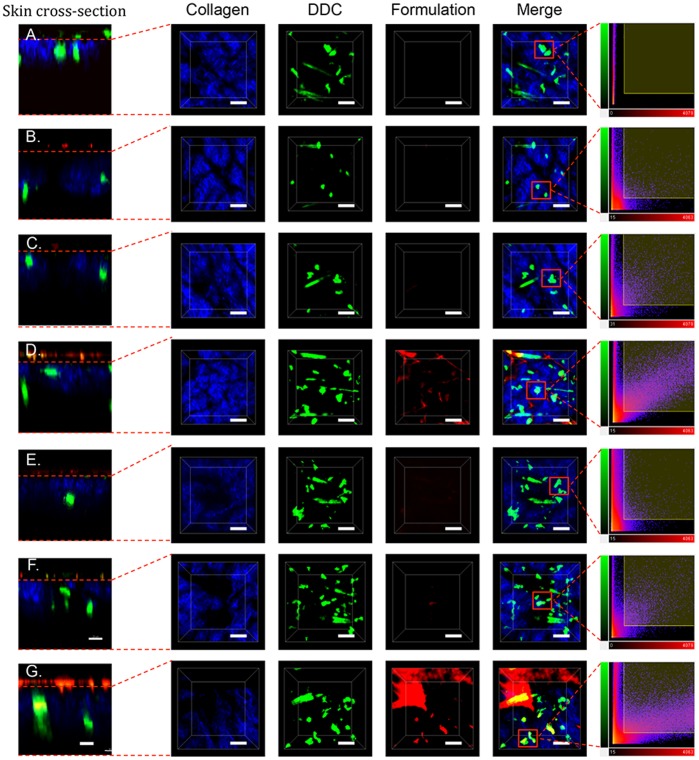
Formulation-DDC colocalization.Two-photon microscopy (2 PM) visualization of collagen (blue), DDC (green) and vaccine (red) in the dermis of untreated mice (A) or 40 min following application of an aqueous TMR-SIINFEKL mixture (B, E), rhodamine-labelled cubosomes (C, F), or TMR-SIINFEKL-loaded cubosomes (D, G) to intact (B-D) or MN pretreated (E-G) skin. Cross sections (XZ, far left) and 3-D images (XYZ) are shown as well as merged images and scatter 2D plots of voxel intensities (far right panel) in the red and green channels for selected DC. Scale bar is 100 µm.